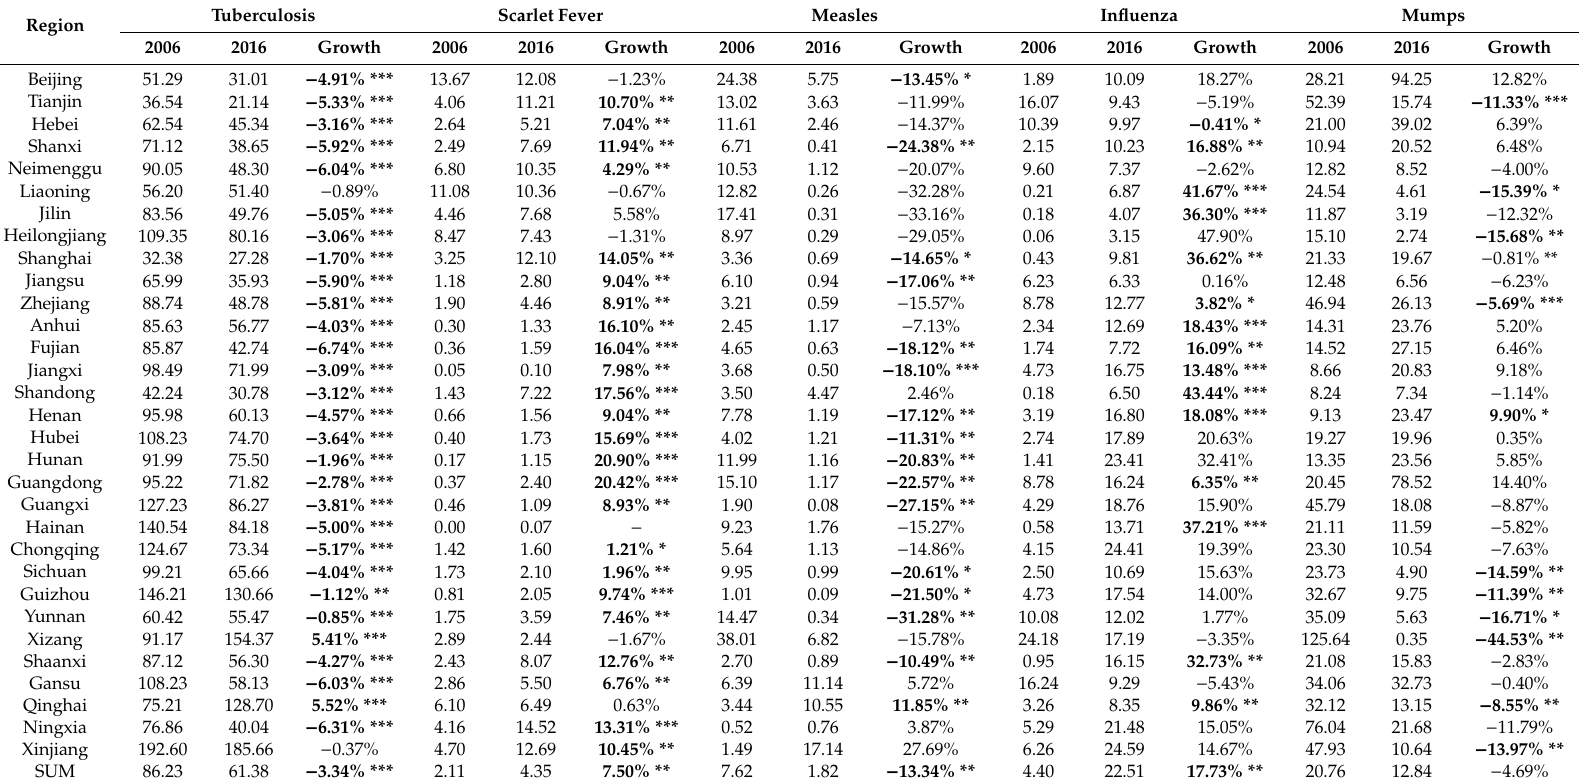
Table 1. The growth in incidence of RIDs in China and the linear test (1 / 100,000) 1